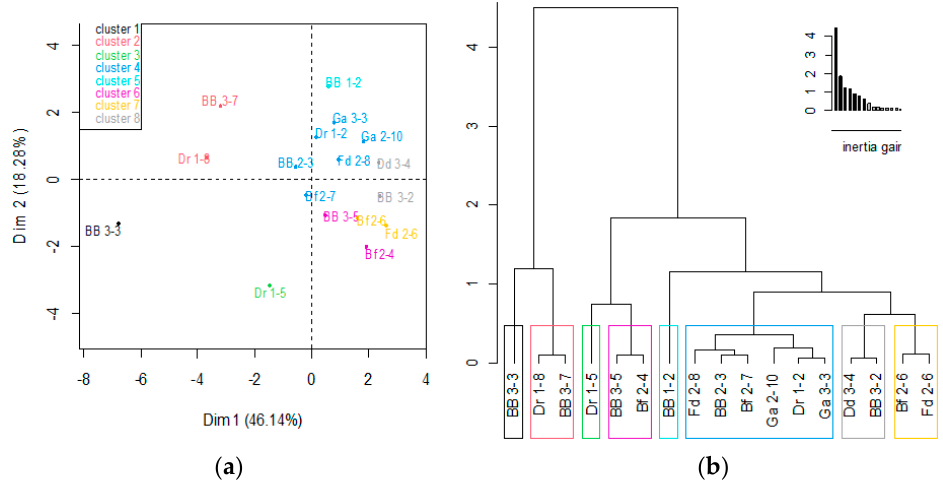
Figure 3. Ascending hierarchical classification of the individuals ( a ) and the hierarchical tree ( b